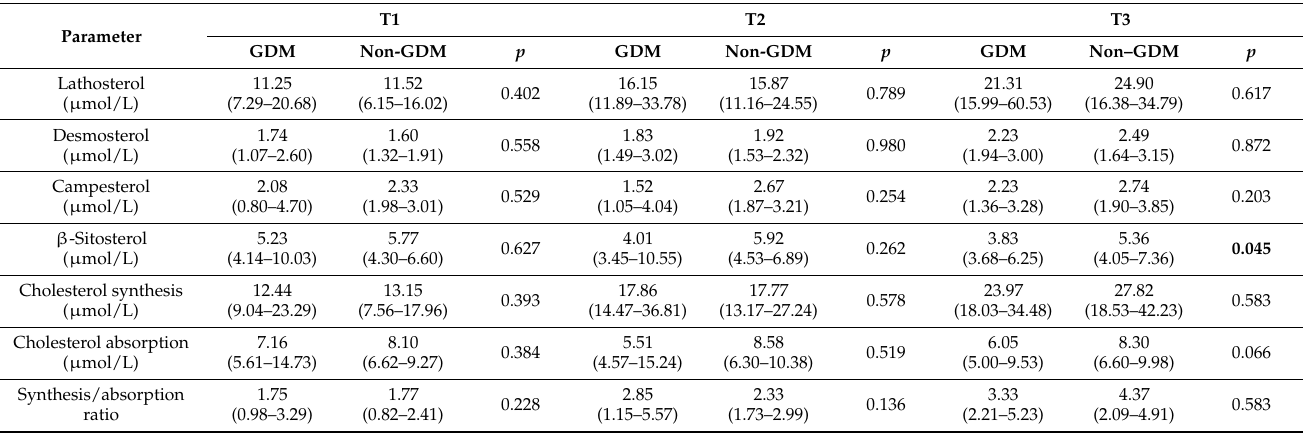
Table 3. Differences in cholesterol synthesis and absorption markers among pregnant women with and without GDM across